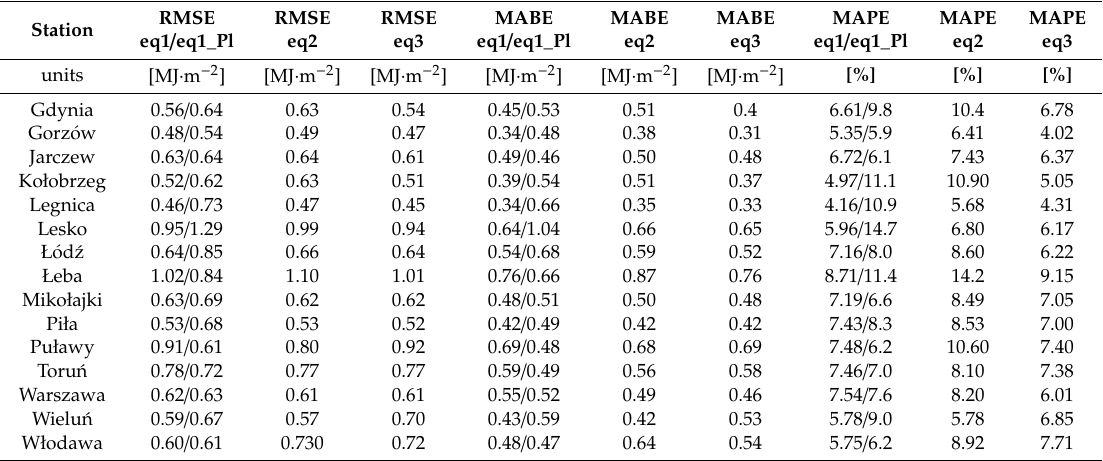
Table 3. Statistical indicators (eq1—Equation 1, eq2—Equation 2, eq3—Equation 3, eq1_Pl Equation 1). Station